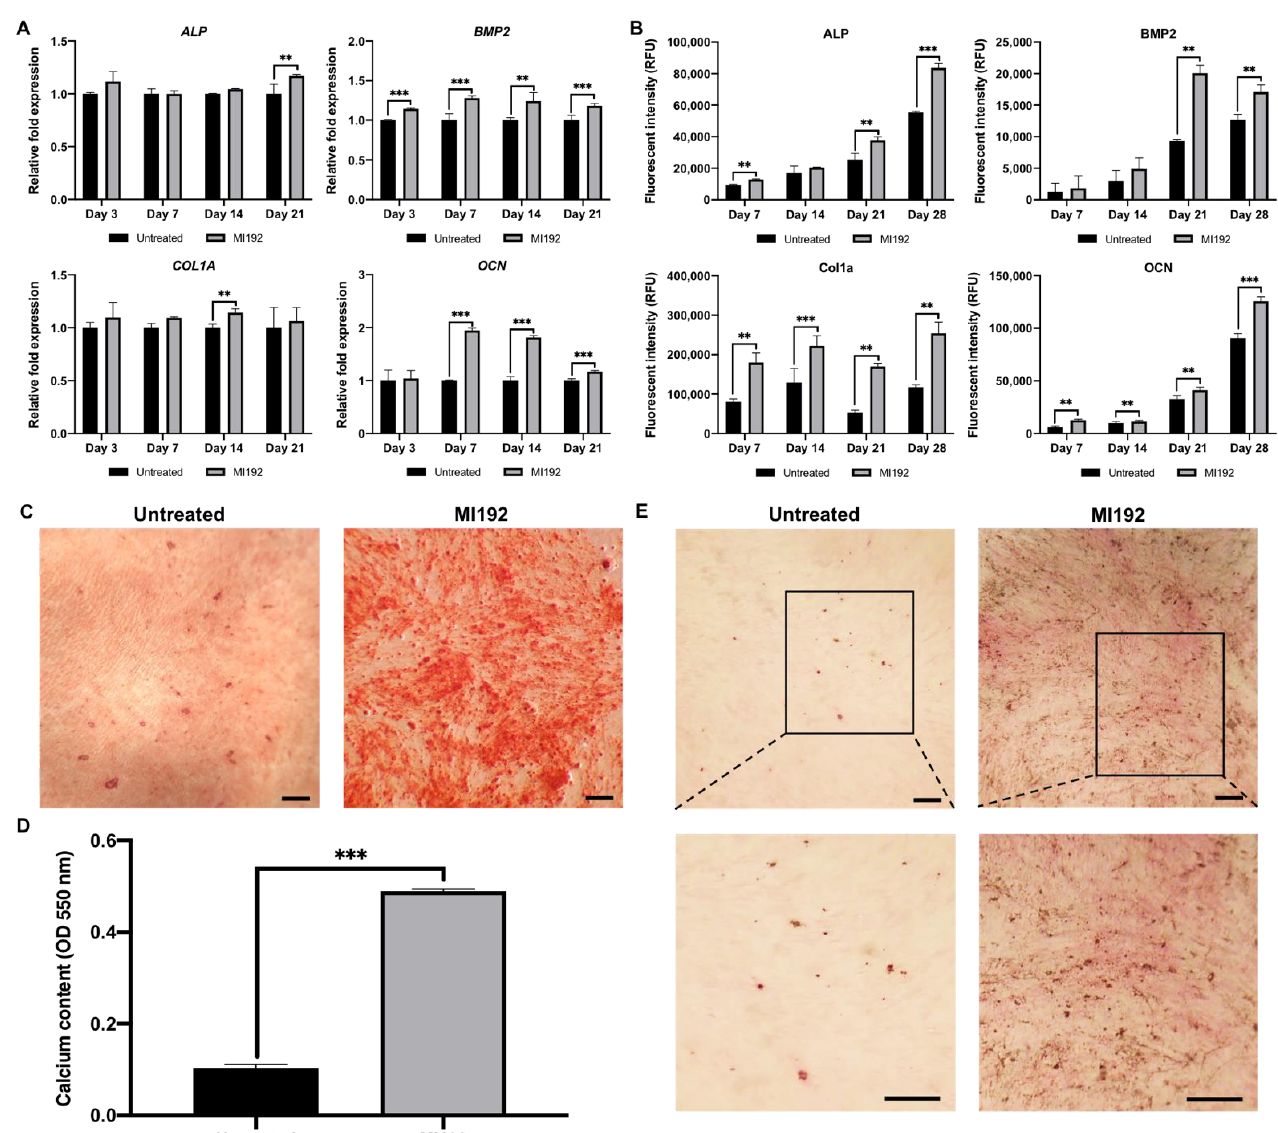
Figure 6. The effects of MI192 pre-treatment (2 µ M MI192 for 48 h) on hDPSCs osteogenic differentiation and mineralisation. Osteoblast-related ( A ) gene expression, ( B ) protein production, ( C , D ) calcium deposition (scale bar = 100 µm)) (day 28) and ( E ) mineral nodule formation (day 28) (scale bar = 50 µm). Data are expressed as mean ± SD ( n = 3). ** p ≤ 0.01 and *** p ≤ 0.001.